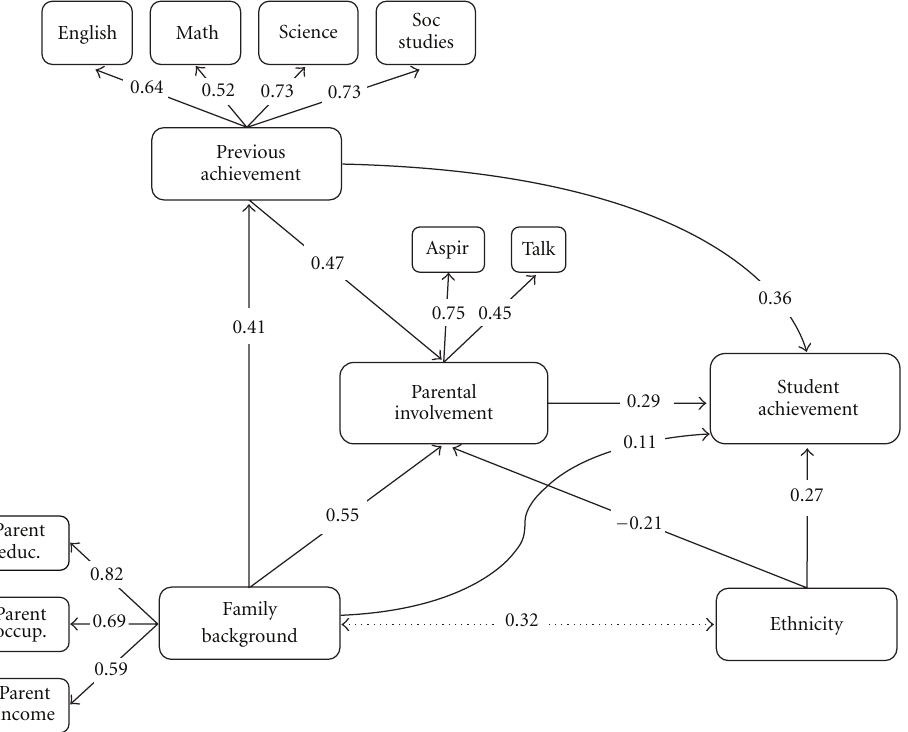
Figure 4: Keith et al.’s [11] structural equation model of parental involvement variables and student achievement. Note: from “Does parental involvement a ff ect eighth-grade student achievement? Structural analysis of national data,” by T. Z. Keith, P. B. Keith, G. C. Troutman, P.